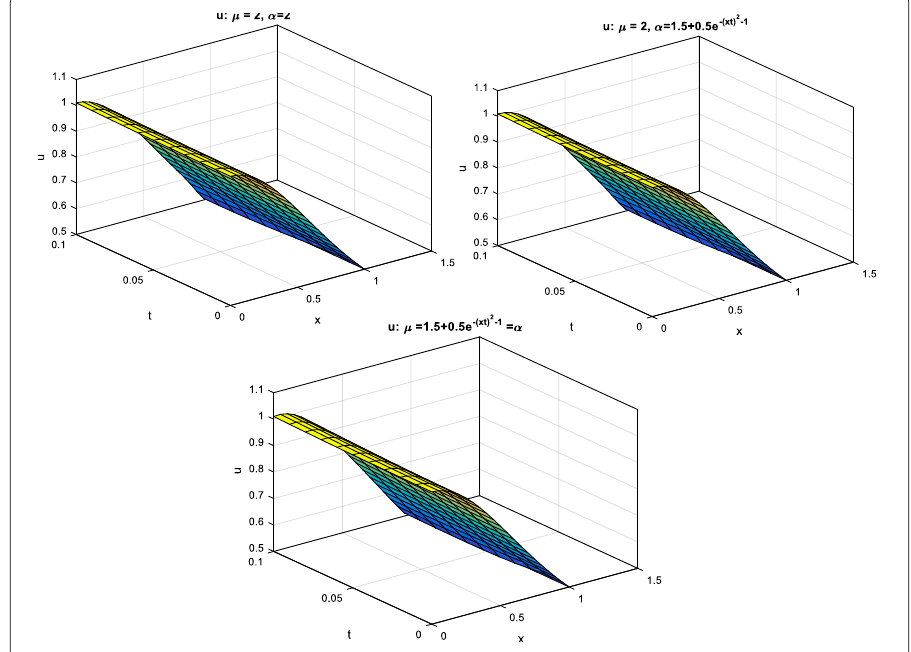
Figure 10 Comparison of the numerical solutions using the introduced method in Example 3 for various values of μ , α